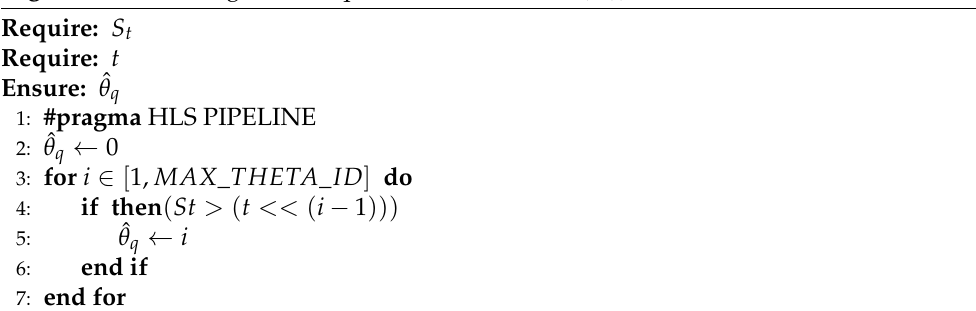
Algorithm 2 Coarse grained θ quantization function ( Q θ )